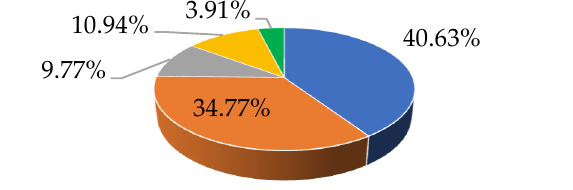
Figure 1. Online teaching prior experience.